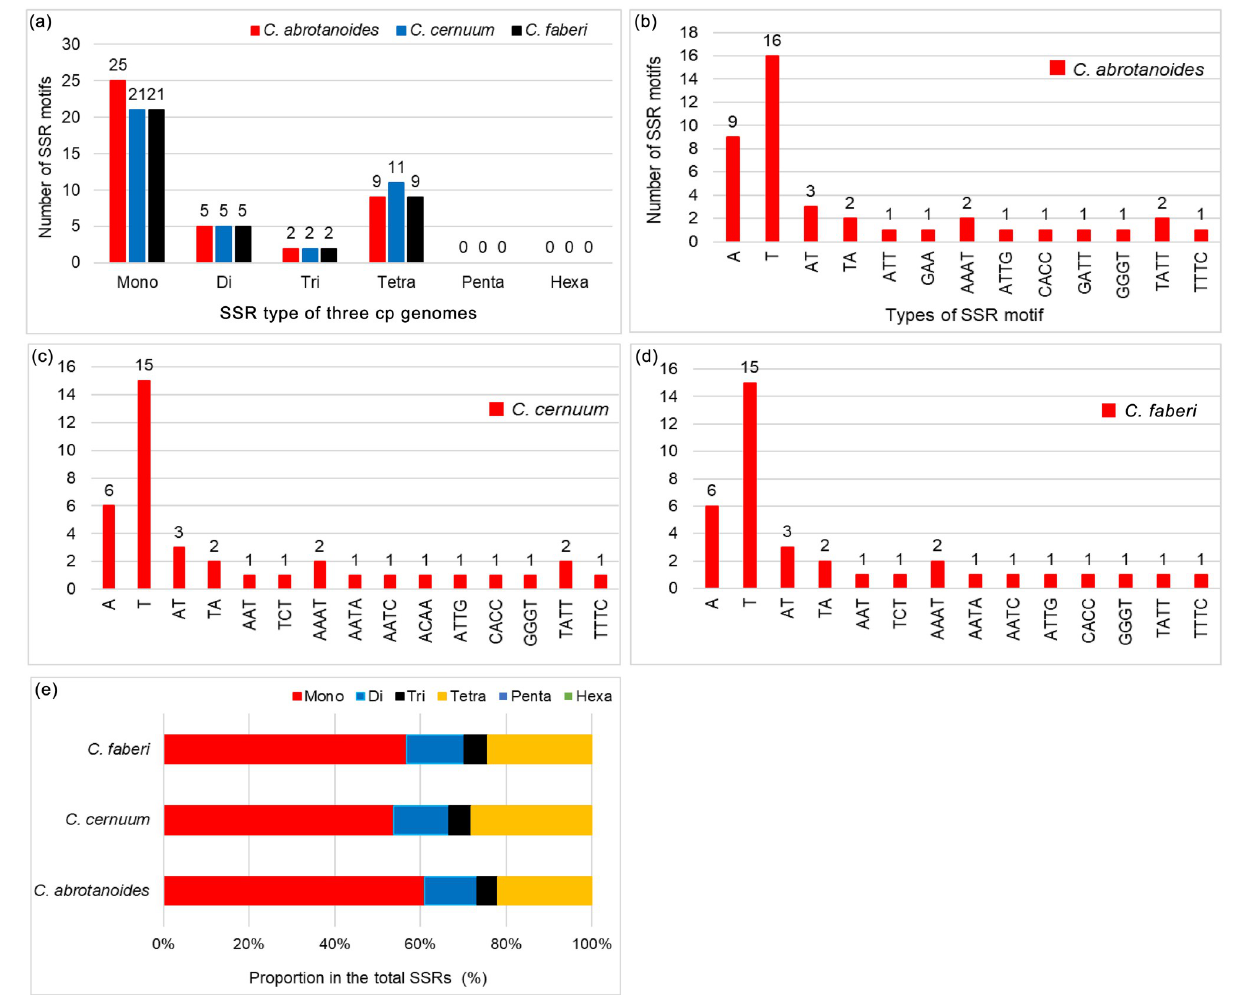
Fig 3. Number and proportion of SSRs in the cp genomes of three Carpesium species. (a) The number of different SSR types. (b-d) The frequencies of different SSR types of three Carpesium species. (e) The proportion of different SSR types.